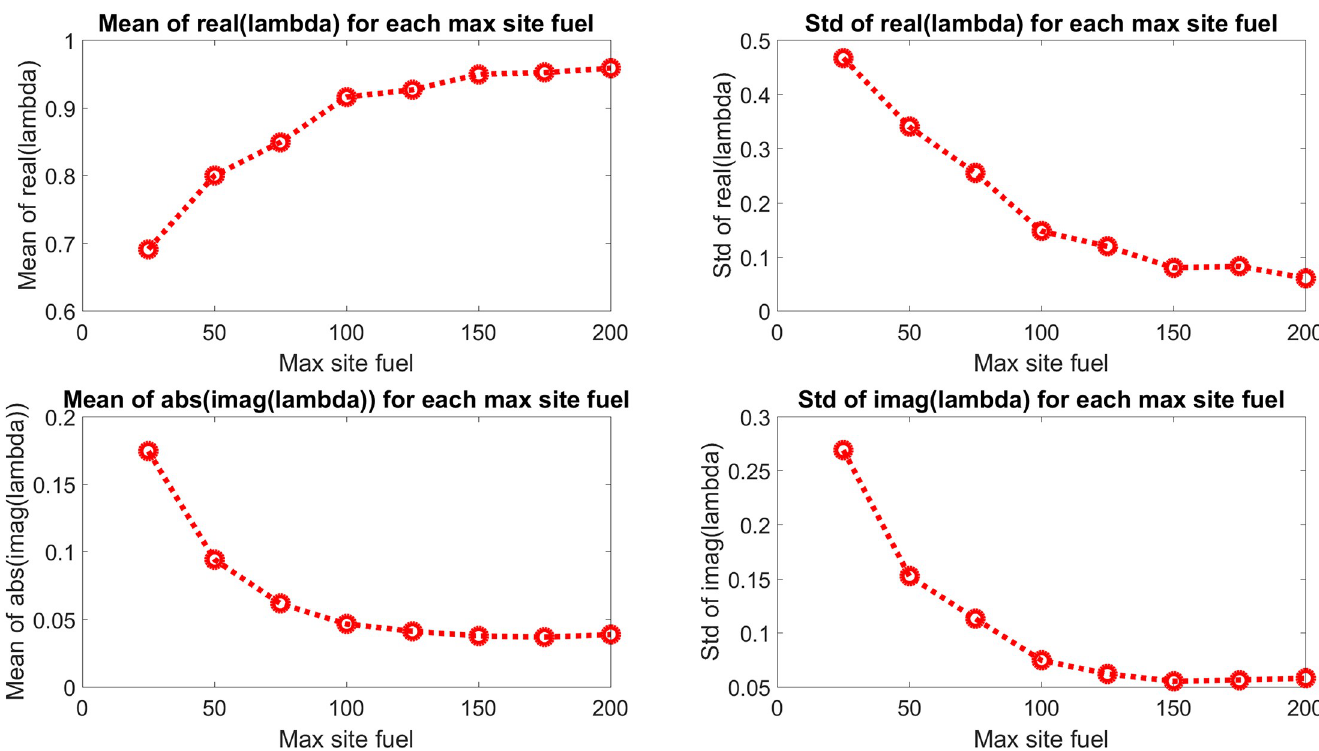
Fig 17. Mean and standard deviation of all eigenvalues for each maximum site fuel value. The real component is seen to go towards the unit circle and the imaginary component goes toward the real axis with increasing maximum site fuel values.